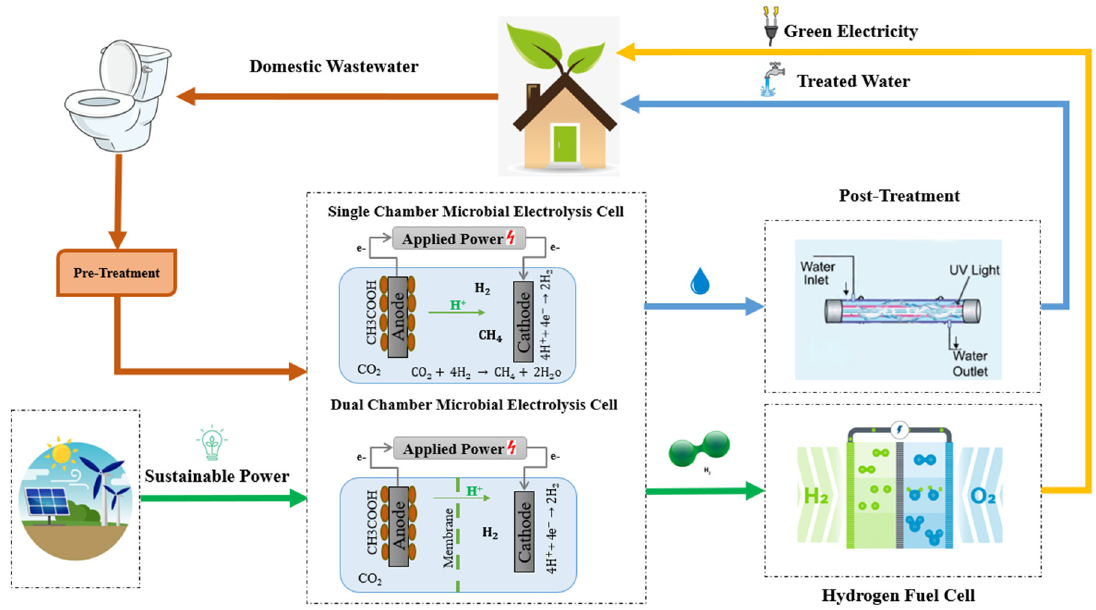
Figure 1. Advanced wastewater treatment and energy recovery cycle.